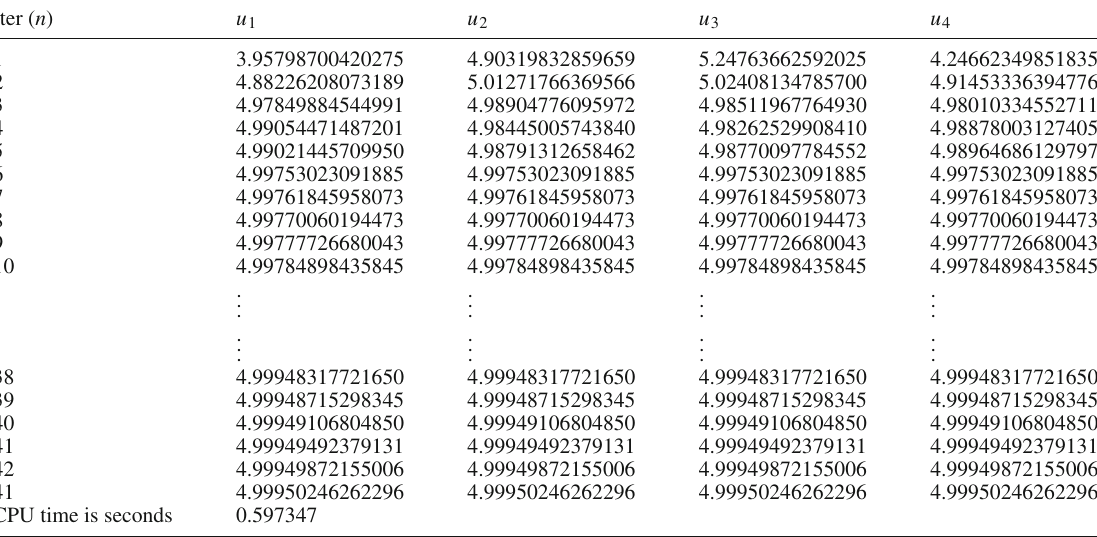
Table 4 Example 4.2: Numerical study of Algorithm 1 in [16] and u 0 = u 1 = ( − 3 , − 4 , 1 , − 5 ) T